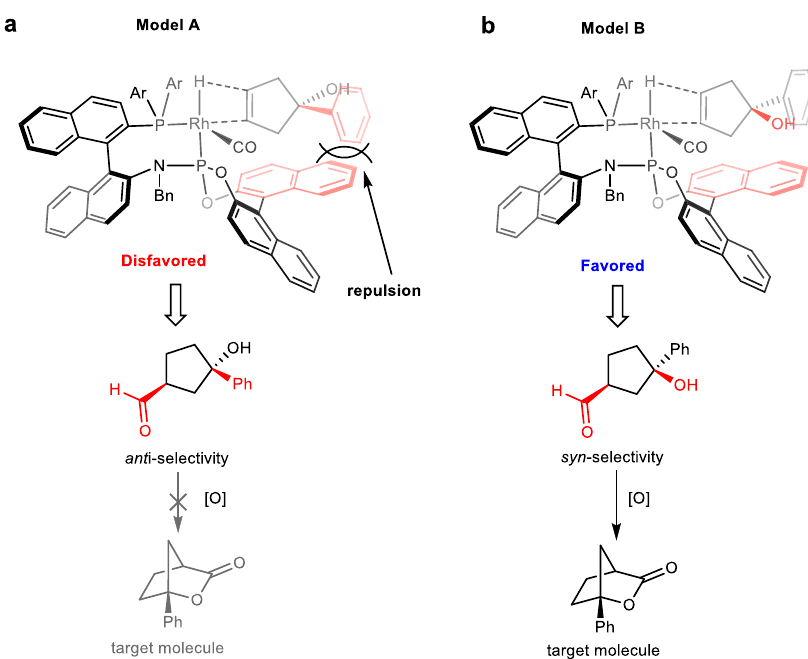
Fig. 7 Proposed stereochemical model. a Disfavored stereochemical model. b Favored stereochemical